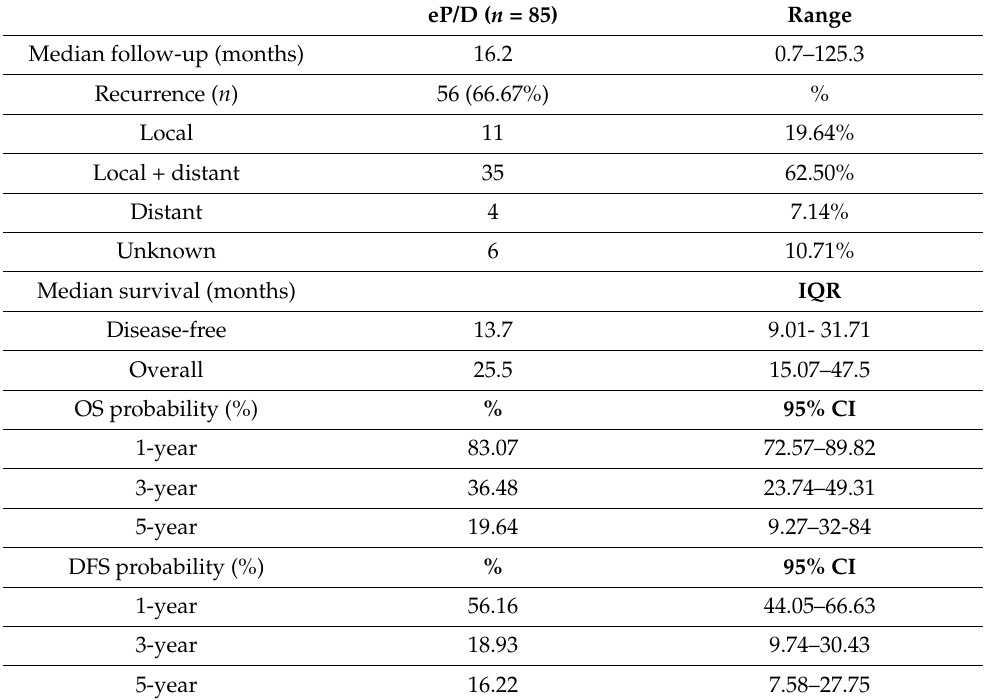
eP/D ( n = 85) Range